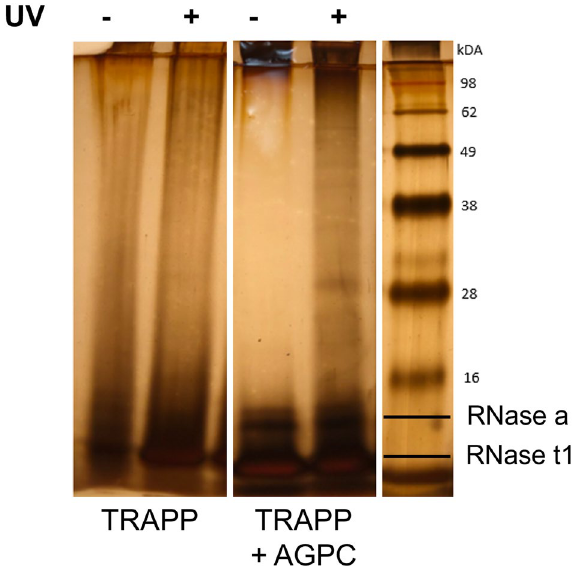
Figure 3. Comparison of non-cross-linked and UV cross-linked sample after TRAPP and after TRAPP + AGPC (= SAPS) visualized by a silver stain assay. A. thaliana; 1 J/cm 2 , treated with RNase before loading, 1 g input material. (full size picture in supplementary data Fig.